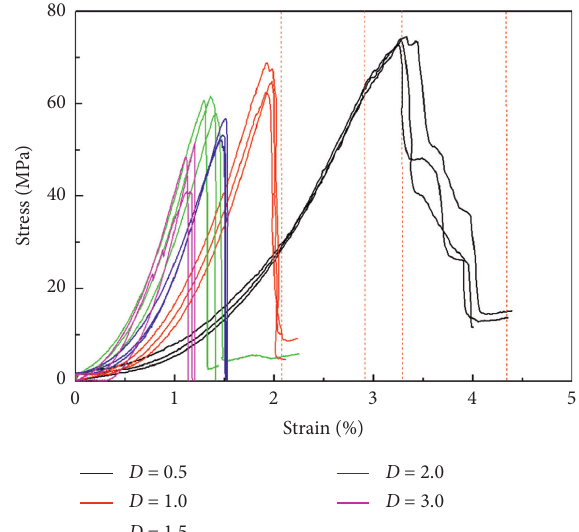
Figure 2: The stress-strain curves of sandstone considering slen- derness ratio ( D